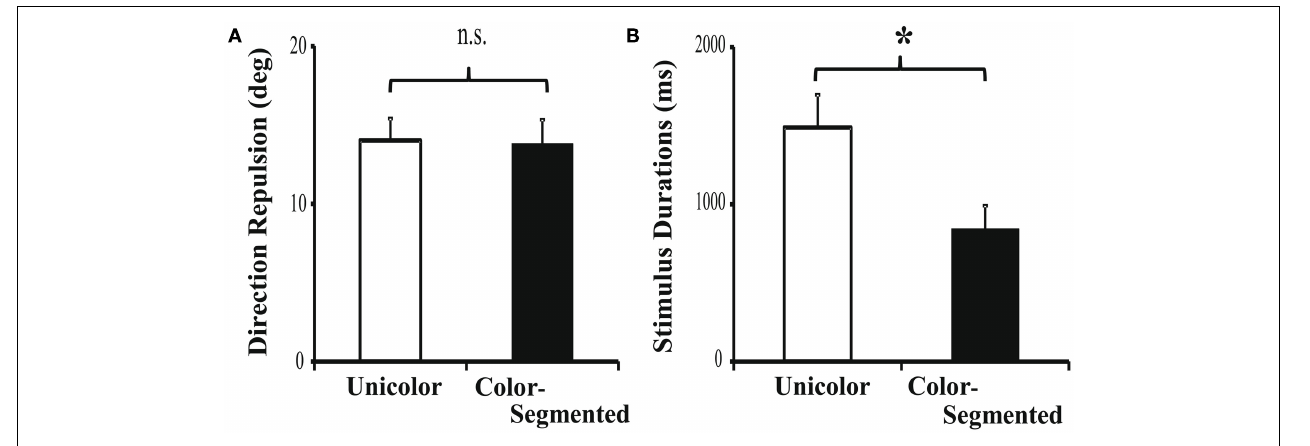
p = 0.91]. (B) Participants required significantly less time in the color-segmented paradigm (841.7 ± 150.5ms) than in the unicolor paradigm (1487.5 ± 208.5ms) to correctly process both directions [ t (22) = 2.51, p = 0.02]. Error bars are